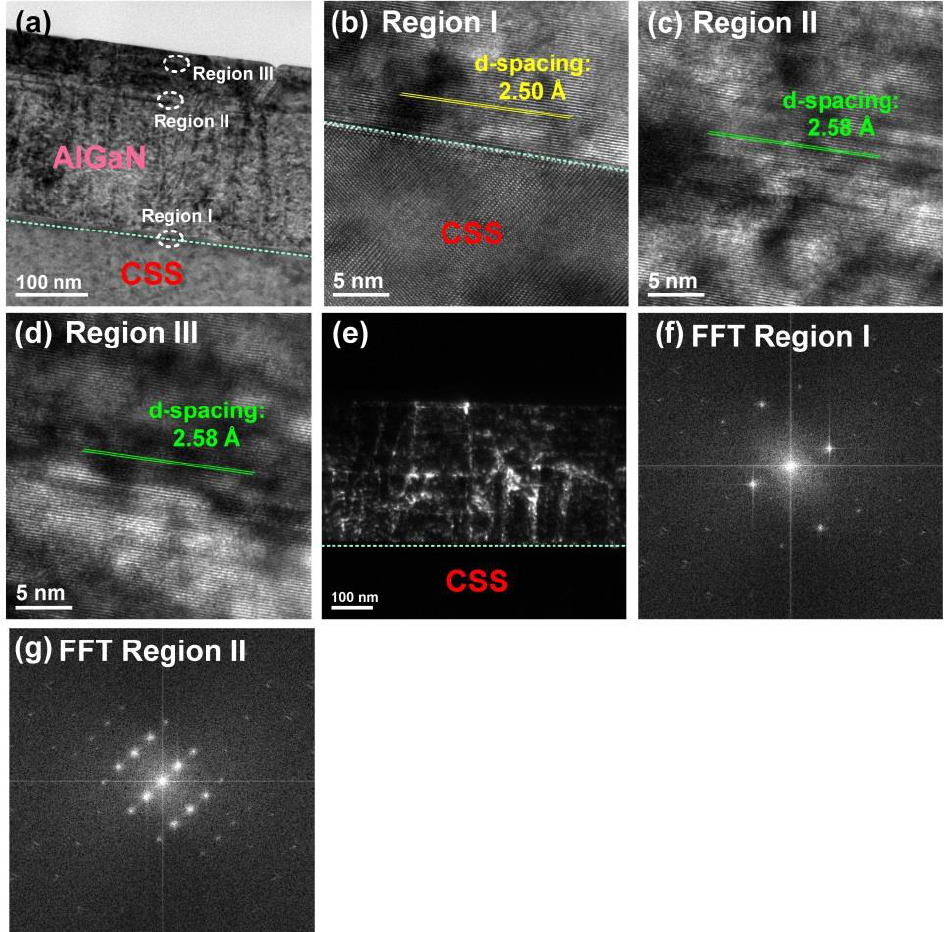
Figure 6. ( a ) A cross-sectional TEM image of the AlGaN/CSS sample. HRTEM images focused on ( b ) region I; ( c ) region II; and ( d ) region III as indicated in Figure 6a. ( e ) The dark-field TEM image observed in the two-beam condition for the AlGaN epilayer deposited on CSS. Fast Fourier transform images for regions ( f ) I and ( g )